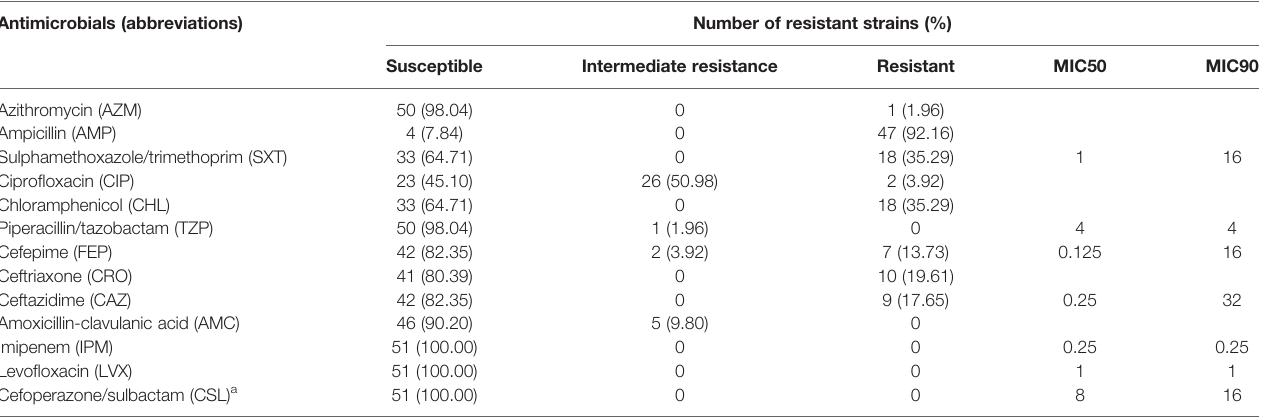
TABLE 1 | Antimicrobial susceptibility pattern of NTS strains in the present study (N = 51). Antimicrobials